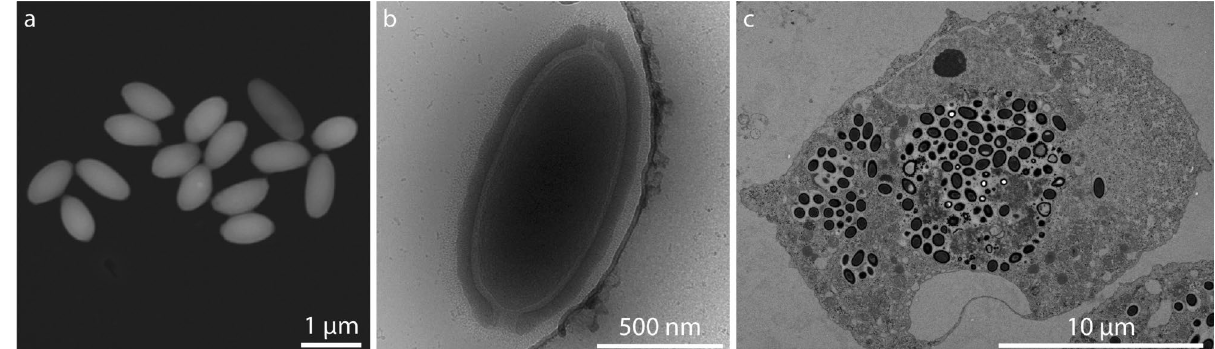
Figure 1. Electron microscopy of virions of Lurbovirus. ( a ) Scanning electron micrograph of isolated virions of Lurbovirus using a scanning transmission electron microscope (STEM) detector in high-angle annular dark-field mode. ( b ) Transmission electron micrograph of a cryo-frozen virion of Lurbovirus. The double cork- like structures indicate morphological similarity to Cedratviruses. ( c ) Transmission electron micrograph of a sectioned, stained, resin-embedded, virus-infected amoeba cell imaged 10 hpi (at 32 °C in medium containing 20 mM glucose). Scale bars are 1 µm, 500 nm and 10 µm,